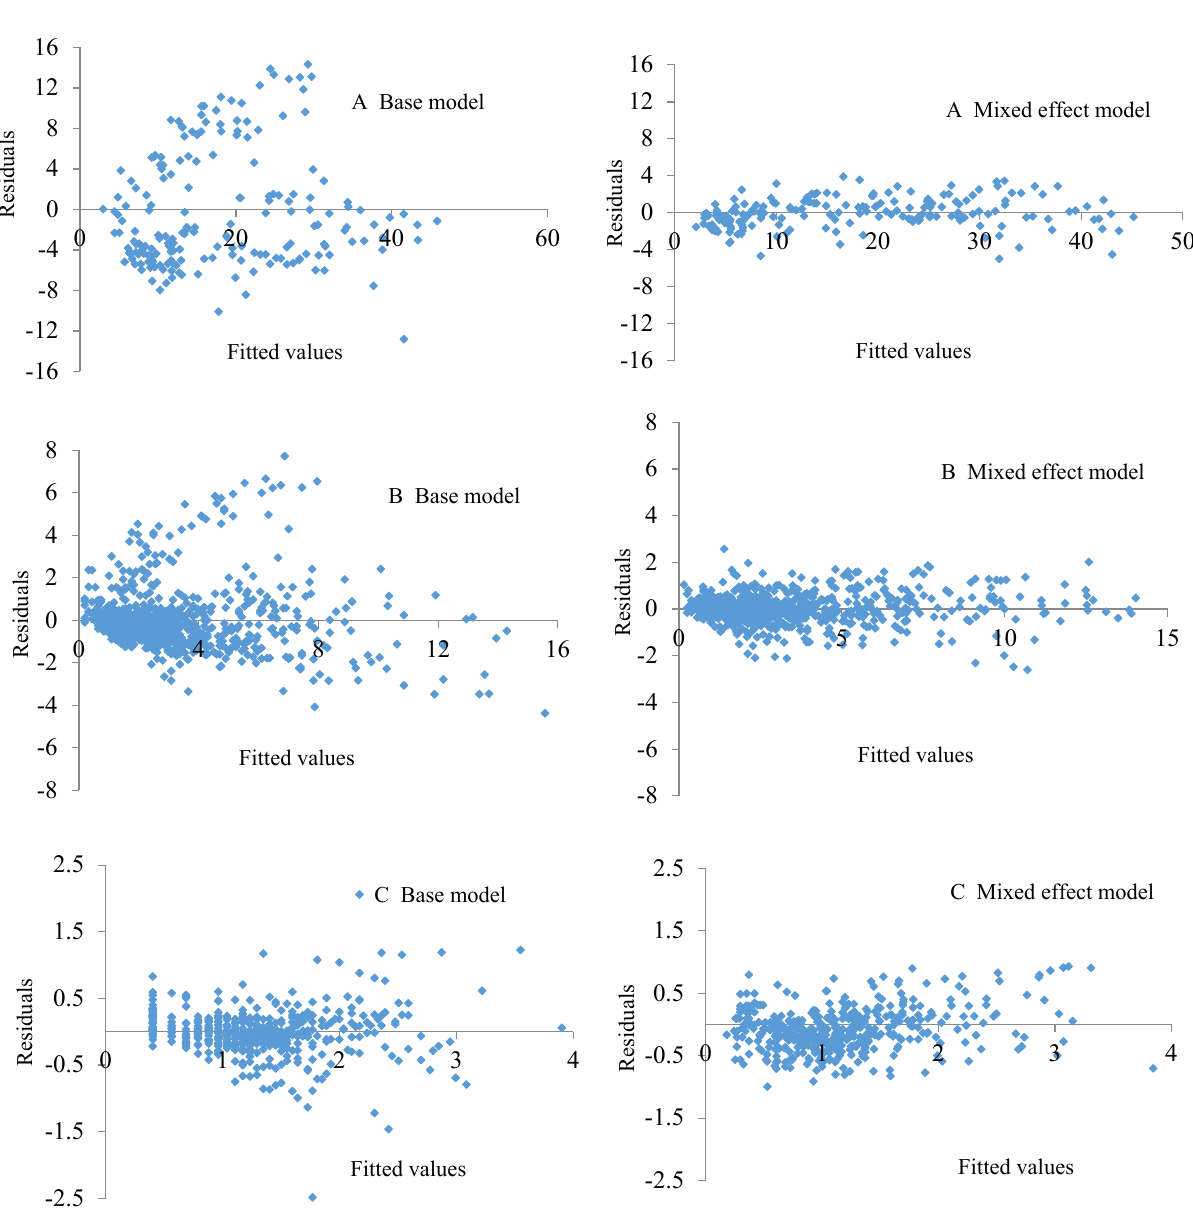
Figure 6. The distributions of residuals for the base models and mixed-effect